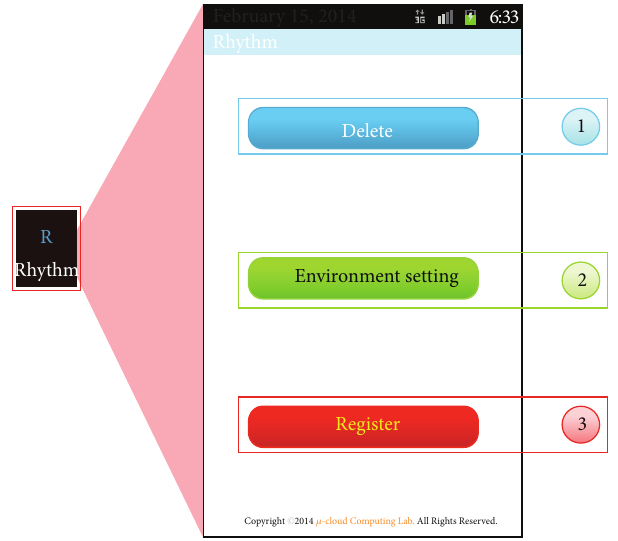
Figure 5: Initial screen of the